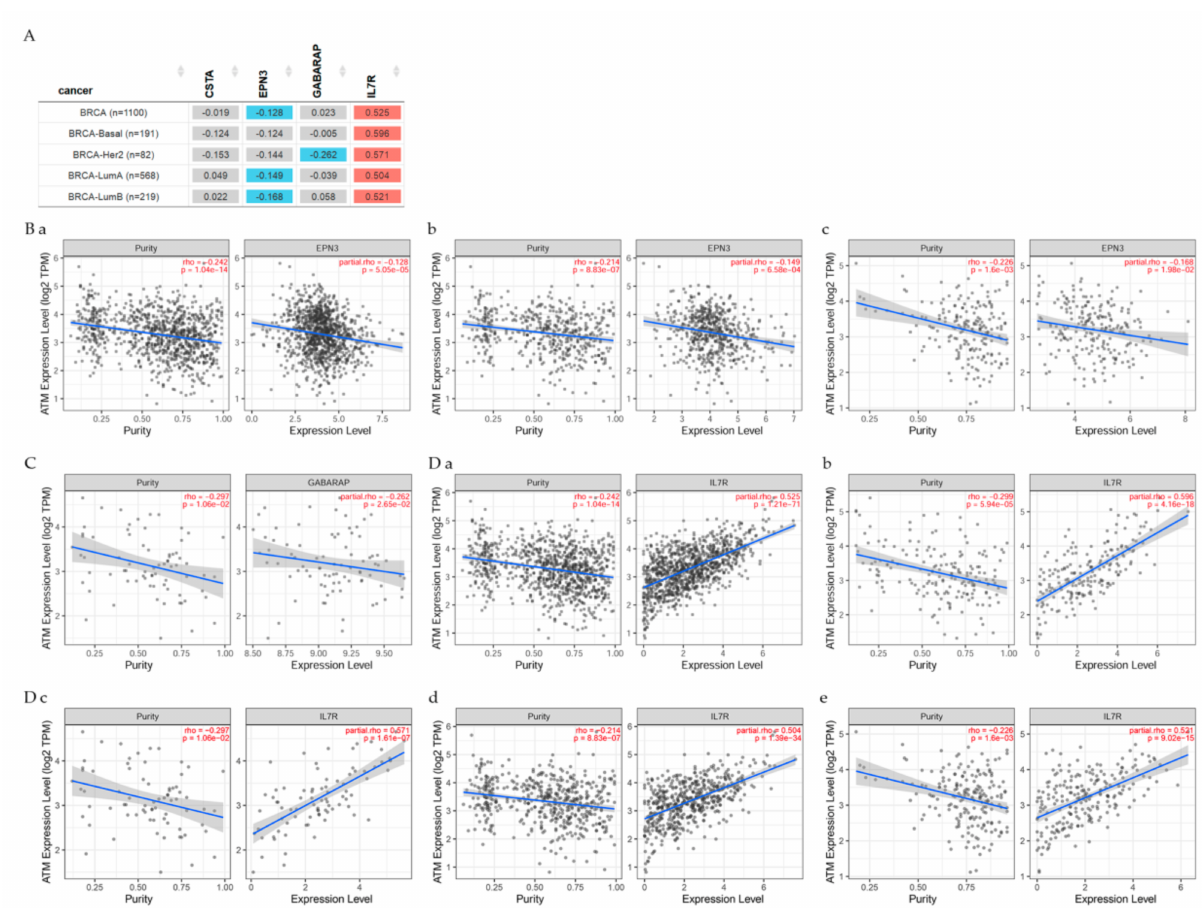
Figure 5. The gene correlation module used to explore the correlation between ATM and genes related to the present studies. ( A ) The table explores the correlations between ATM gene expression and other genes in BRCA patient types. These figures show the correlation between ATM gene expression and ( B ) EPN3 in ( a ) All BRCA, ( b ) BRCA-LumA, and ( c ) BRCA-LumB; ( C ) GABARAP in BRCA-Her2; ( D ) IL7R in ( a ) All BRCA, ( b ) BRCA-Basal, ( c ) BRCA-Her2, ( d ) BRCA-LumA, and ( e )